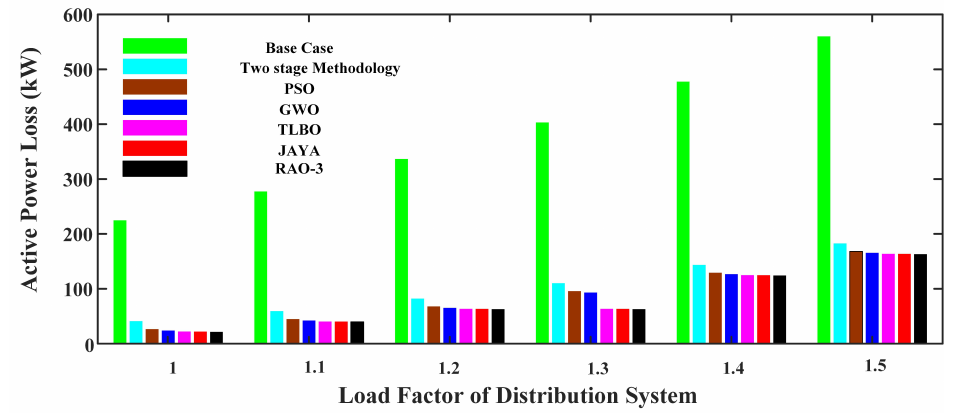
Figure 15. The impact of the rising DST system load on the performance of the 69-bus radial distribution system.